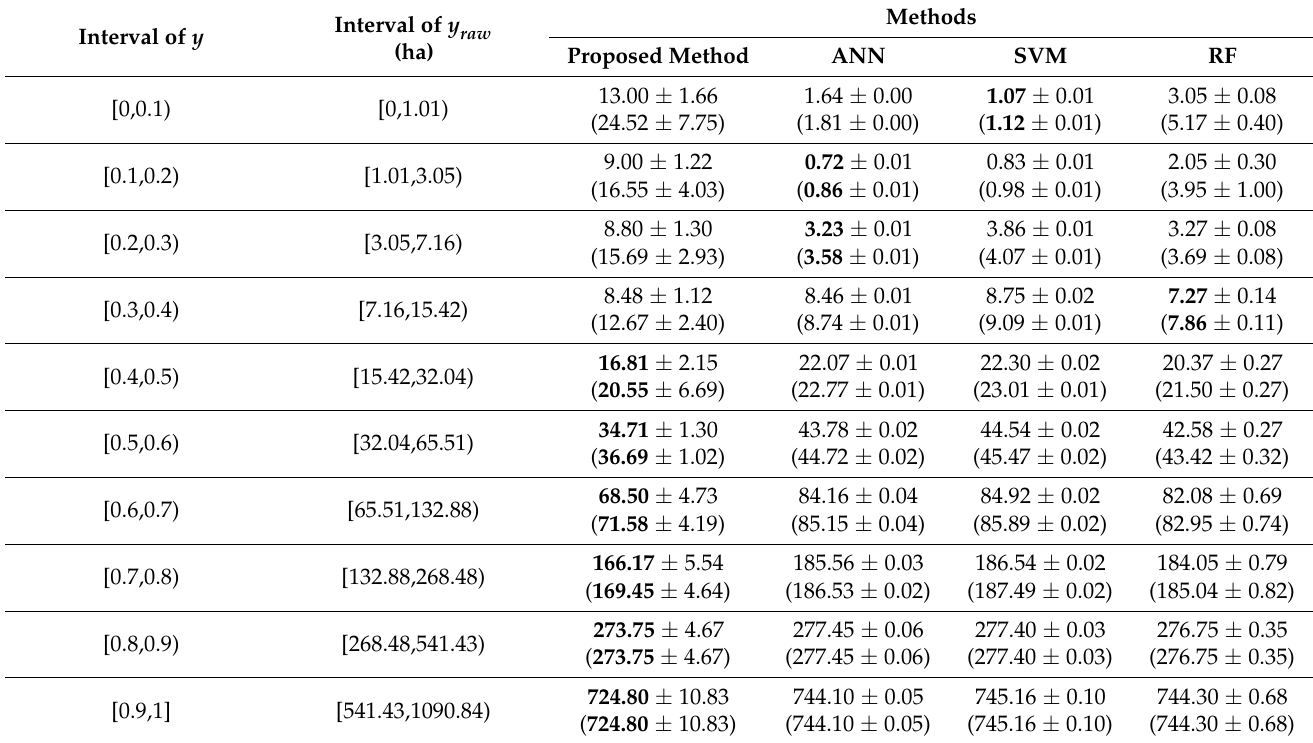
Table 2. Segmented performance of different methods in form of MAE average and standard deviation ( RMSE average and standard deviation), the best performance in each interval is reported in bold .